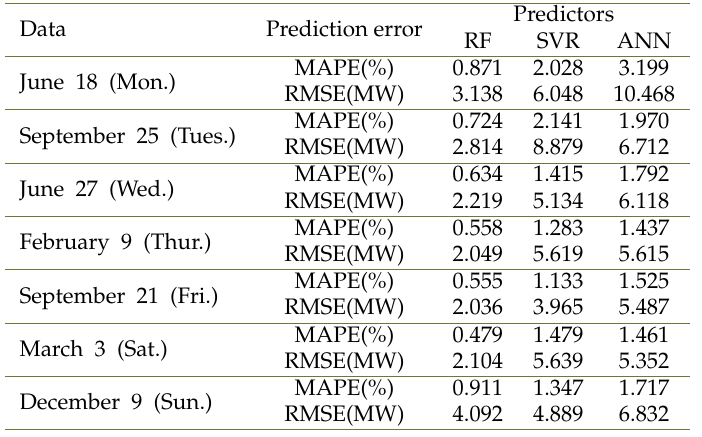
Table 2. Prediction error of different predictors of the selected seven test days with really attempt when 1-h-ahead predic- tion is conducted.